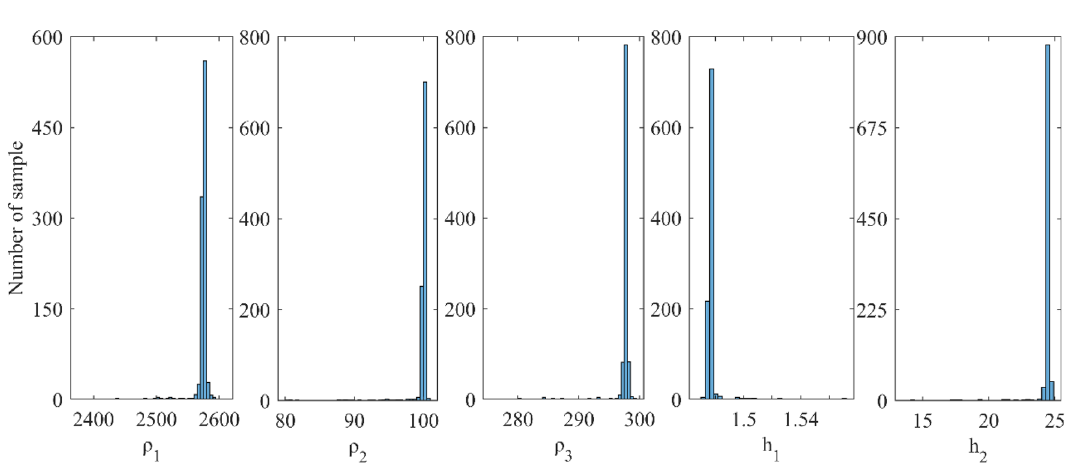
Figure 6. A number of samples versus vPSOGWO inverted layer parameters for three-layered noisy DC synthetic